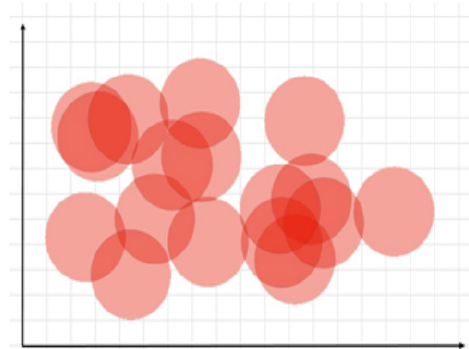
Fig. 1. The graphical method of creation of a Heat Map with overlapping buffers